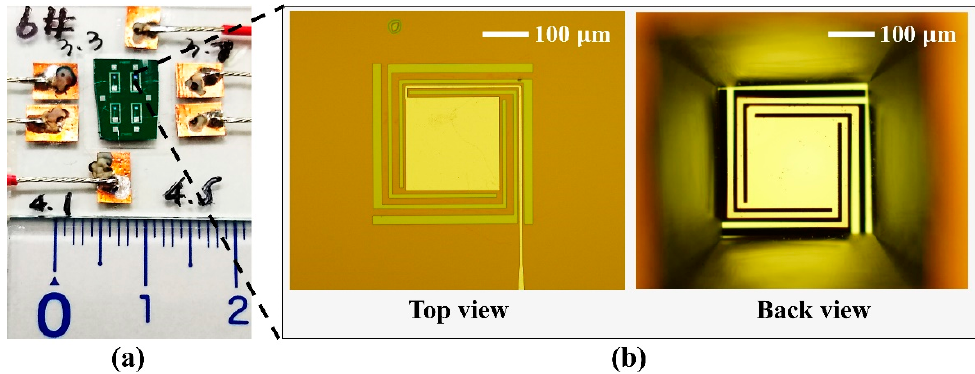
Figure 6. ( a ) Photo of a fabricated MEMS-based hybrid plasmonic–pyroelectric detector. ( b ) Microscope images of the top view and back view of the fabricated sensing element.